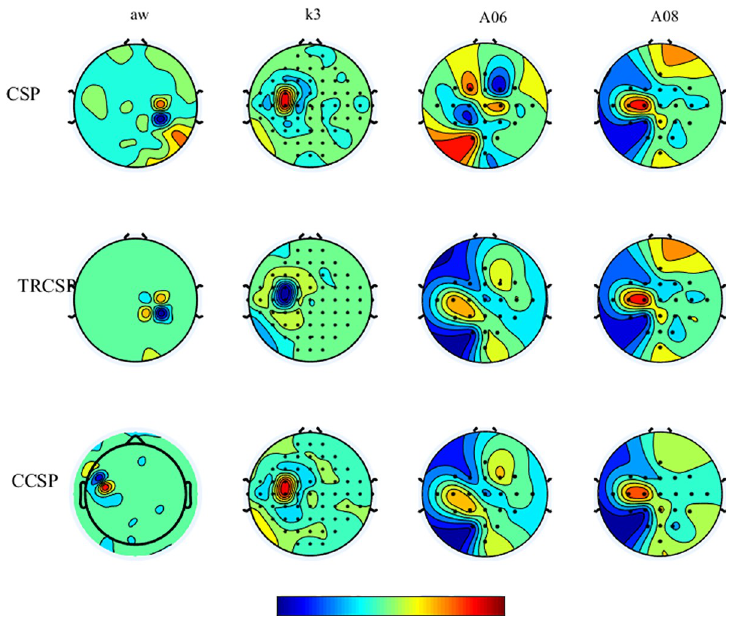
Fig 9. The scalp topography for the first spatial filter using CSP, TRCSP and CCSP methods for the subjects aw, k3, A06 and A08.